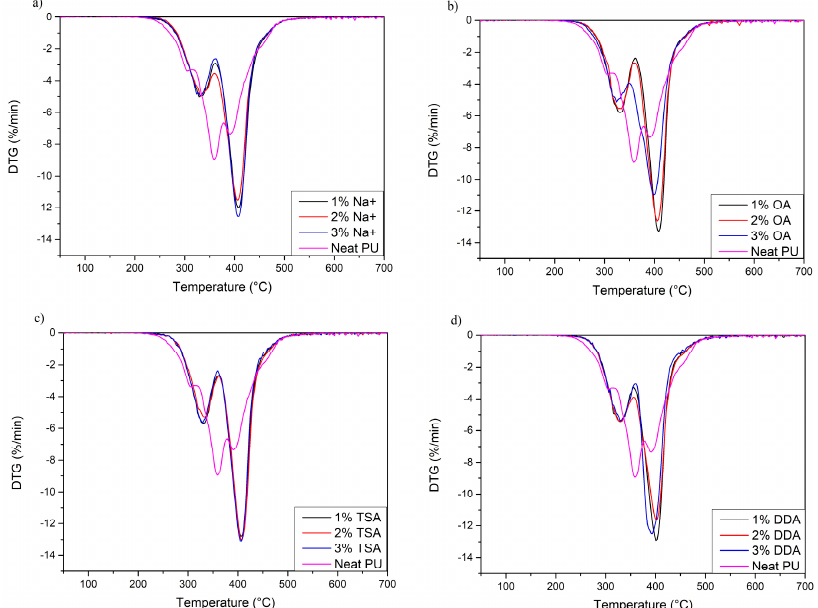
Figure 3. DTG curves of neat PU and manufactured nanocomposites. ( a ) Na+ samples; ( b ) OA samples; ( c ) TSA samples; ( d ) DDA samples.